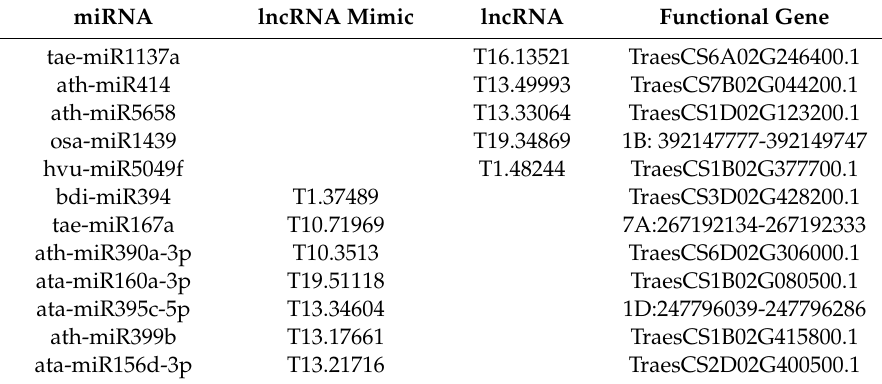
Table 3. The list of DE-lncRNAs / lncRNA mimics with allele-specific gene targeted by the same miRNA. miRNA lncRNA Mimic lncRNA Functional